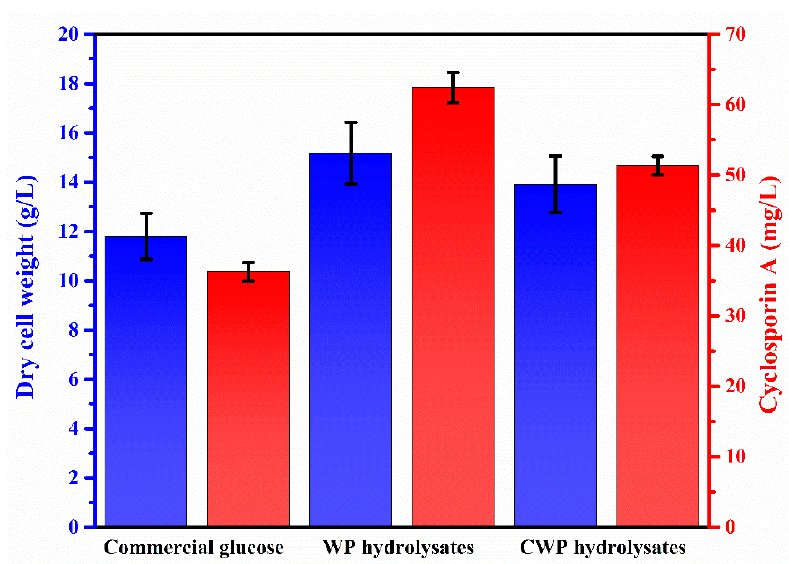
Figure 6. Cyclosporin A production by Tolypocladium inflatum ATCC 34921 using three carbon sources (commercial glucose, whey powder (WP) hydrolysates, and cheese whey power (CWP) hydrolysates).